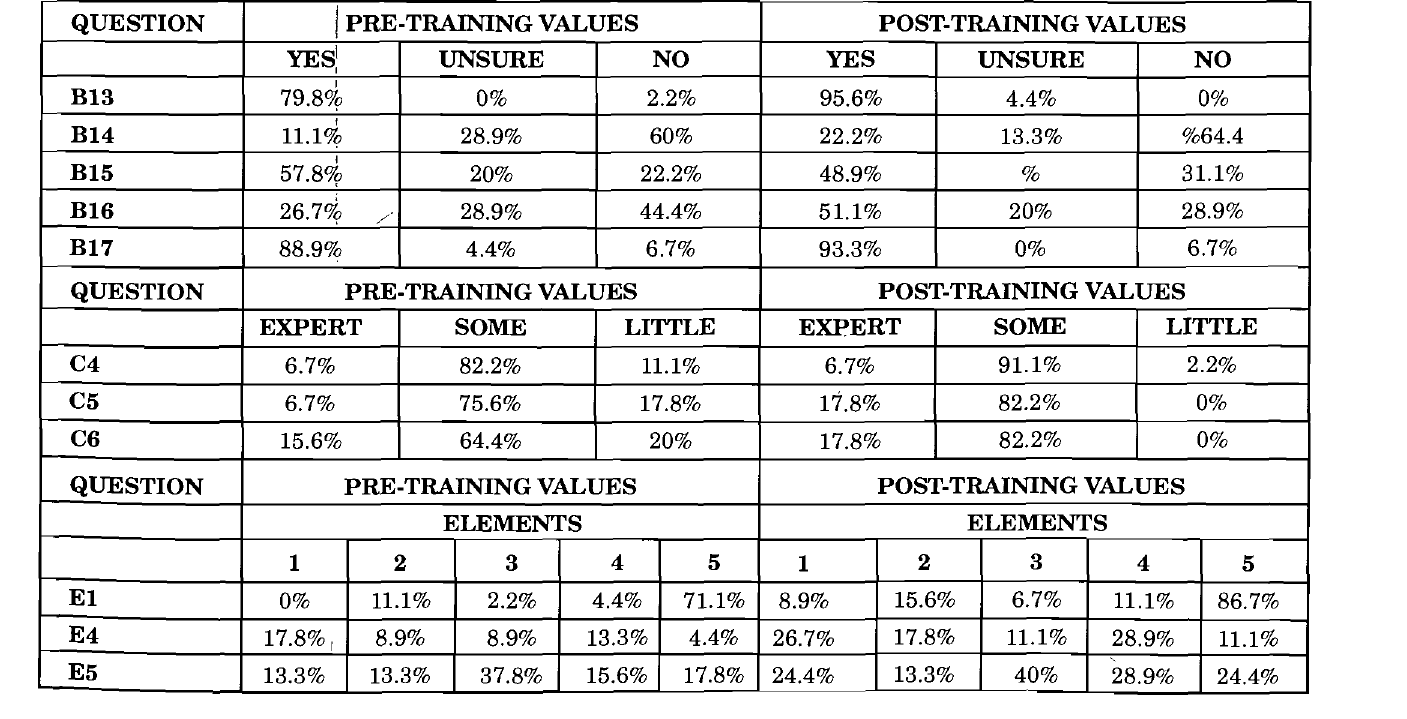
TABLE 6: The change in ~europsychological Skills (SN) and Metacognitive Skills (SM) QUESTION